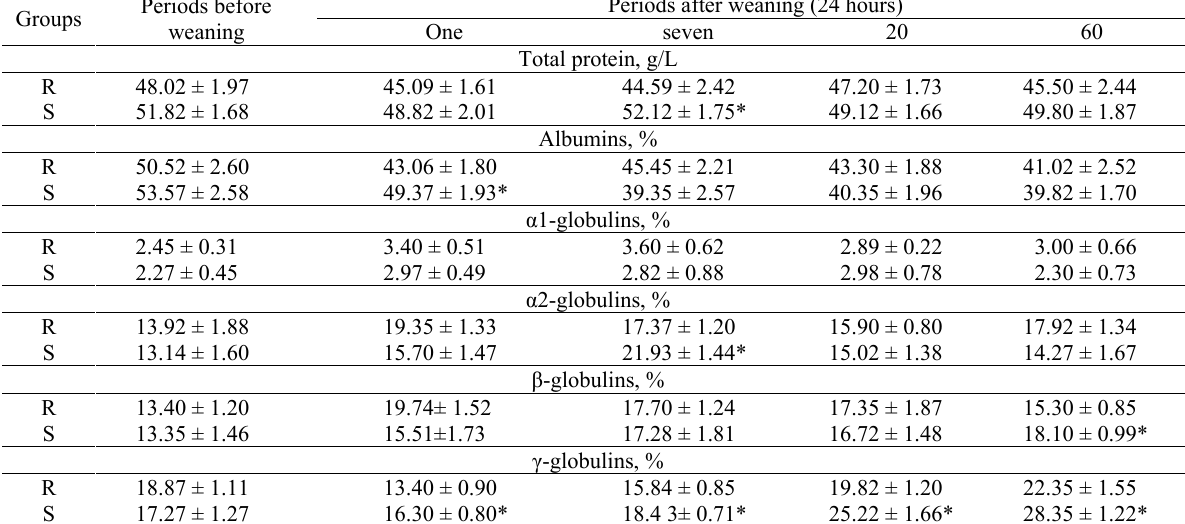
Periods after weaning (24